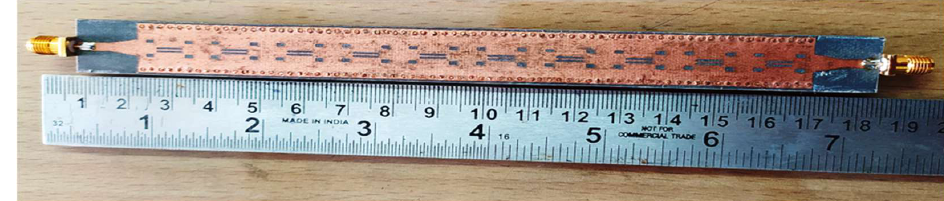
Figure 5. Fabricated prototype of SIW LWA.